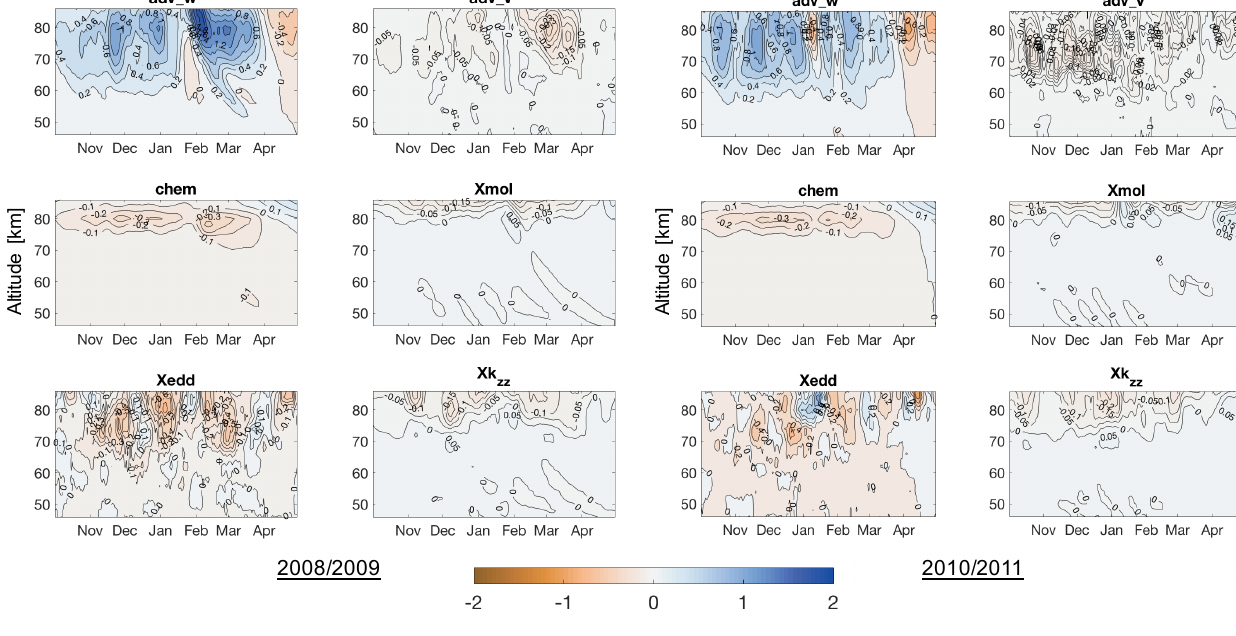
Figure 4. The same as Fig. 3, but for 80 ◦ N.